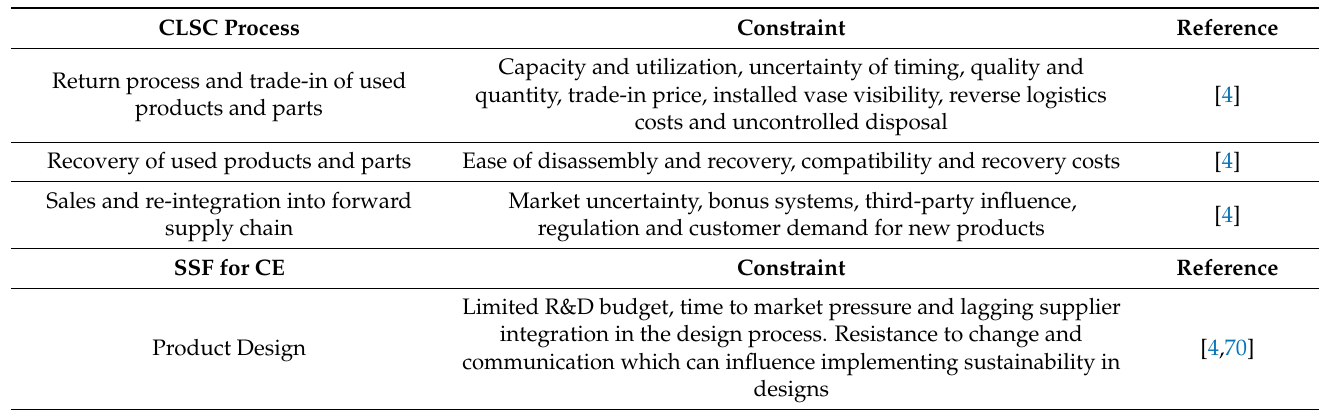
Table A1. Constraints for CLSC